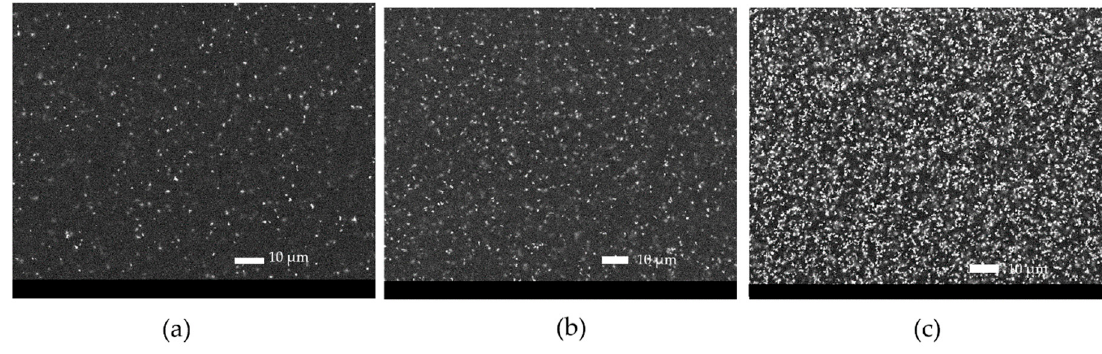
Figure 10. SEM (BED) pictures of the sample 3 wt.% at time 0 ( a ) and after 96 h ( b ) and 288 h ( c ) of UV-B exposure.